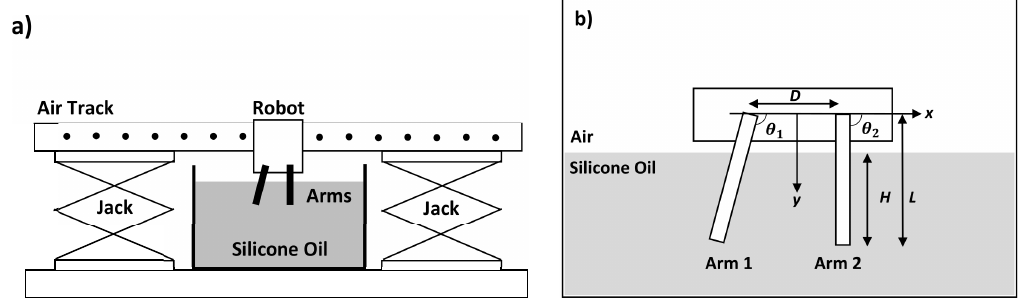
Figure 1. ( a ) Sketch of the experimental setup. The air track is placed on top of two jacks. The robot glides on the air track and the arms of the robot are dipped in a tank of silicone oil. ( b ) The arms are of length L = 40mm and separated by a distance D = 23mm. They are dipped H = 30mm into a tank of silicone oil. The orientation angles of Arms 1 and 2, θ 1 and θ 2 , respectively, are controlled by